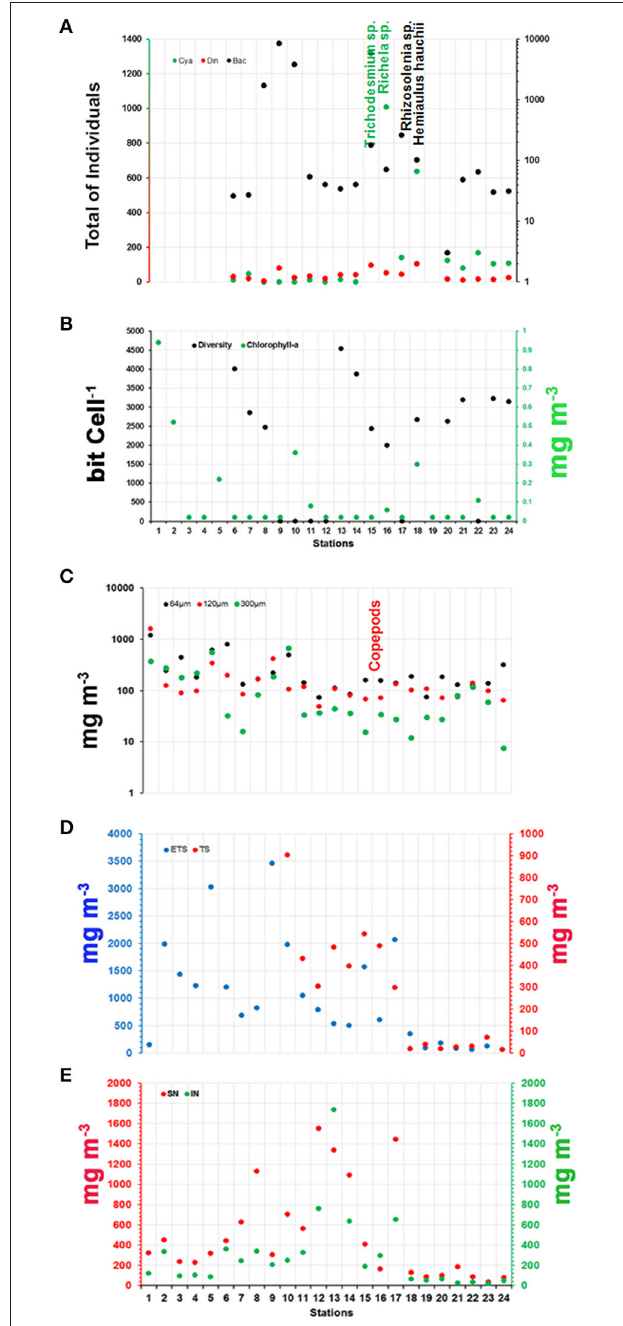
FIGURE 7 | Distributions of (A) Phytoplankton groups; (B) Diversity and Chl-a; (C) Zooplankton groups; (D) Vertical biomass of zooplankton; and (E) Neuston biomass along the ship track during the CF3 cruise, October 2012. The most representative species of each group (phytoplankton and zooplankton) are shown in vertical orientation in (A,C) , respectively. The location of the species in the figure indicates the region of most representative of them.